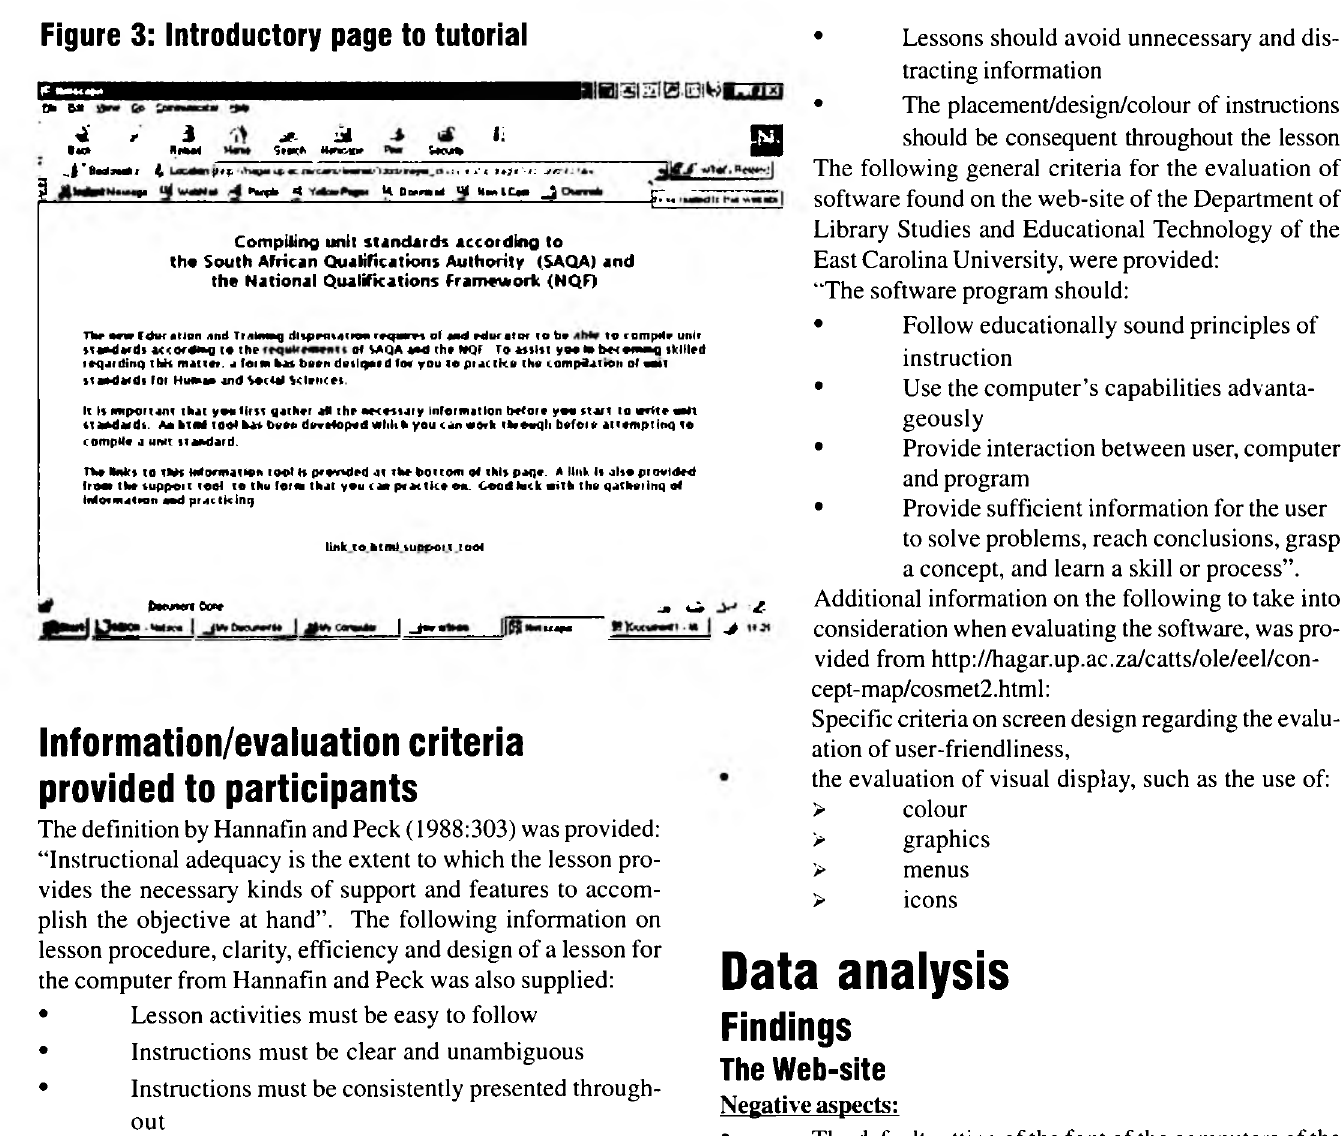
Figure 4: Sitemap for